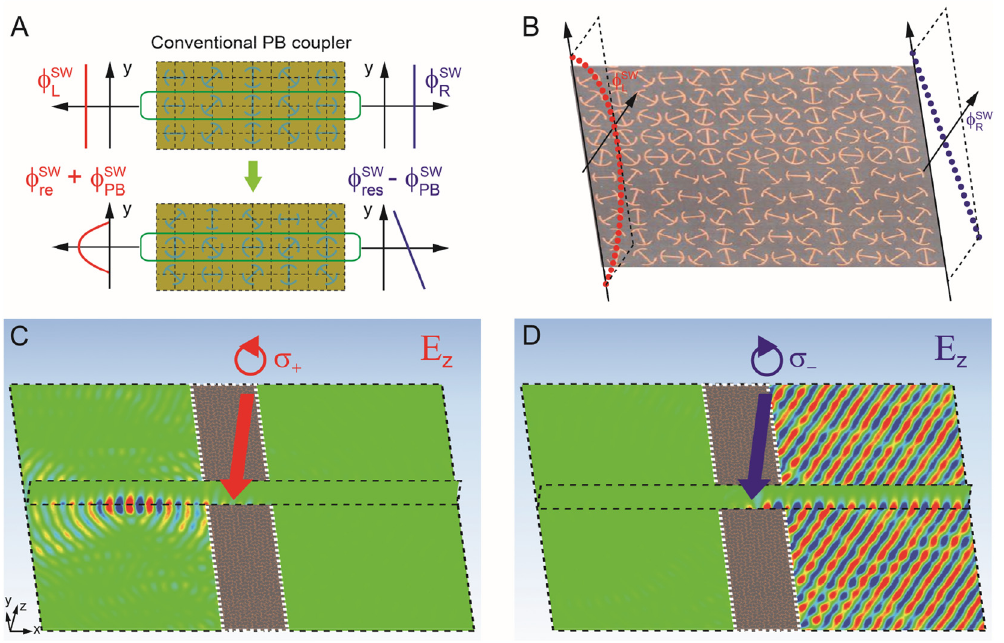
Figure 3: Helicity-delinked metasurface for near- fi eld SW manipulations: numerical demonstrations. (A) Comparison between a conventional PB meta-coupler and a helicity-delinked bi-functional meta-coupler. (B) Part of the proposed meta- coupler for generating SWs with either hyperbolic or linear phase profile dictated by the helicity of input CP waves. (C, D) FEM simulated near- field Re[ E z ] patterns on the whole system, as the meta-coupler is illuminated by CP waves with σ (cid:1) + and σ (cid:1) − ,